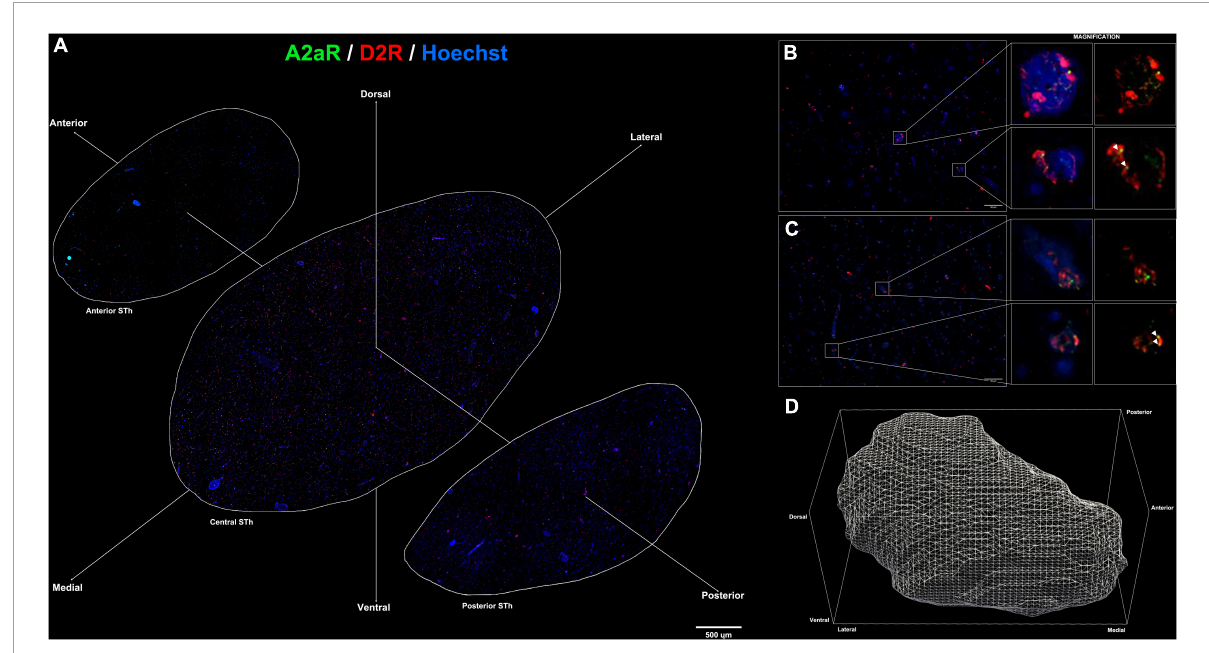
FIGURE3 (A) Immunofluorescent staining for A 2 A R (green) and D 2 R (red) throughout the rostro-caudal extent of the subthalamic nucleus reveals a peculiar topographical distribution. (B,C) colocalization of A 2 A R and D 2 R proteins within the subthalamic nucleus (white arrows). (D) 3D representation of the structure of the subthalamic nucleus following reconstruction of serial sections.